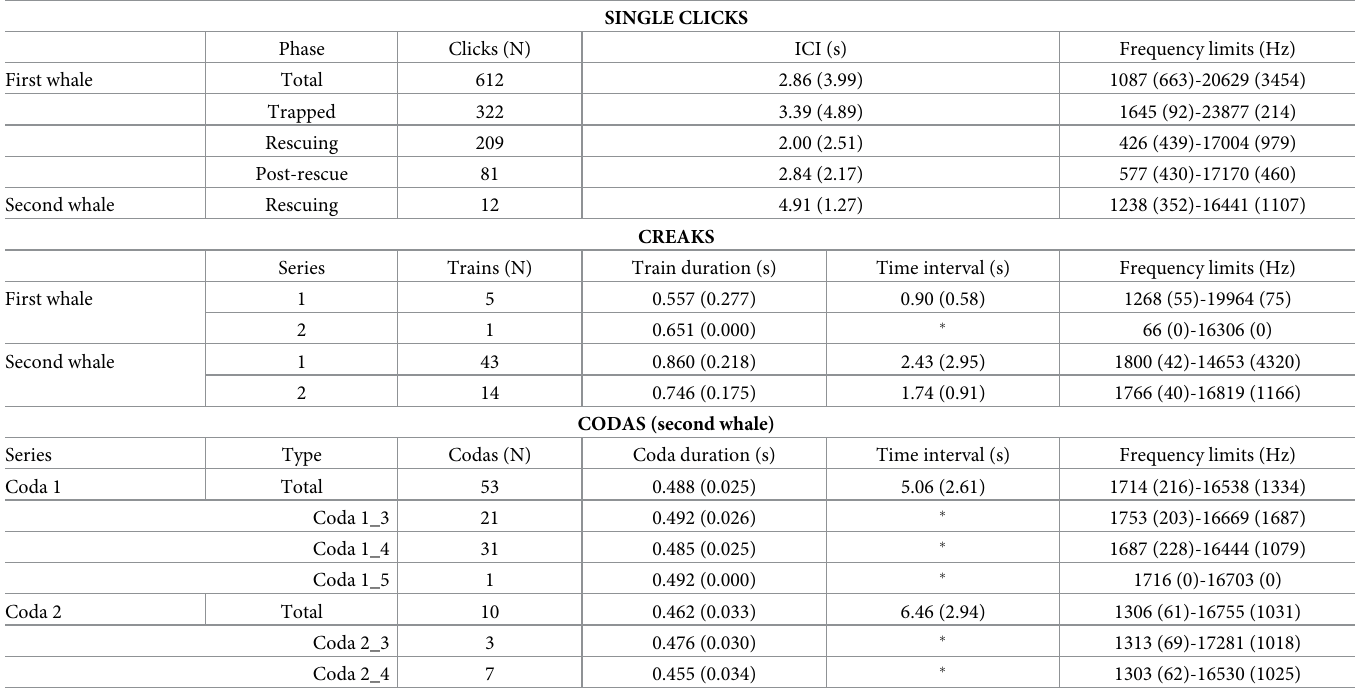
Table 1. Each sound emission type temporal and physical